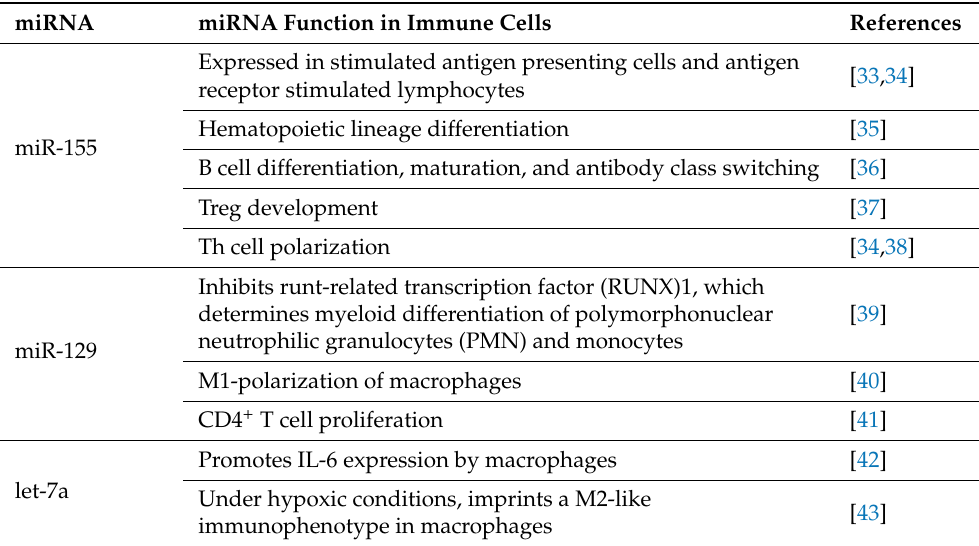
Table 1. Overview of immune cell functions mediated by miRNAs whose maturation is promoted by KSRP.